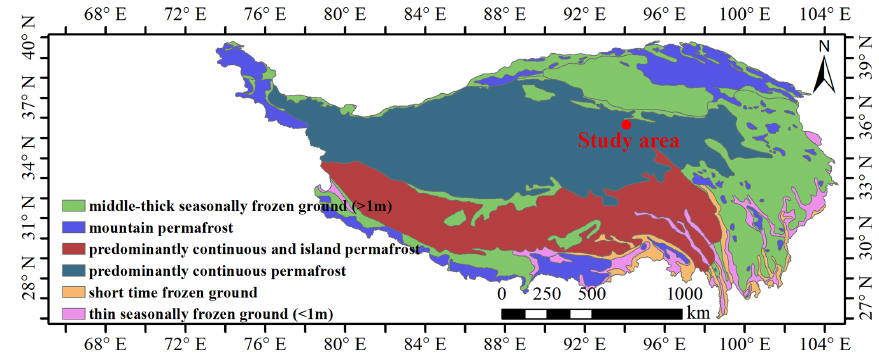
Figure C1. The frozen soil distribution in the study area.